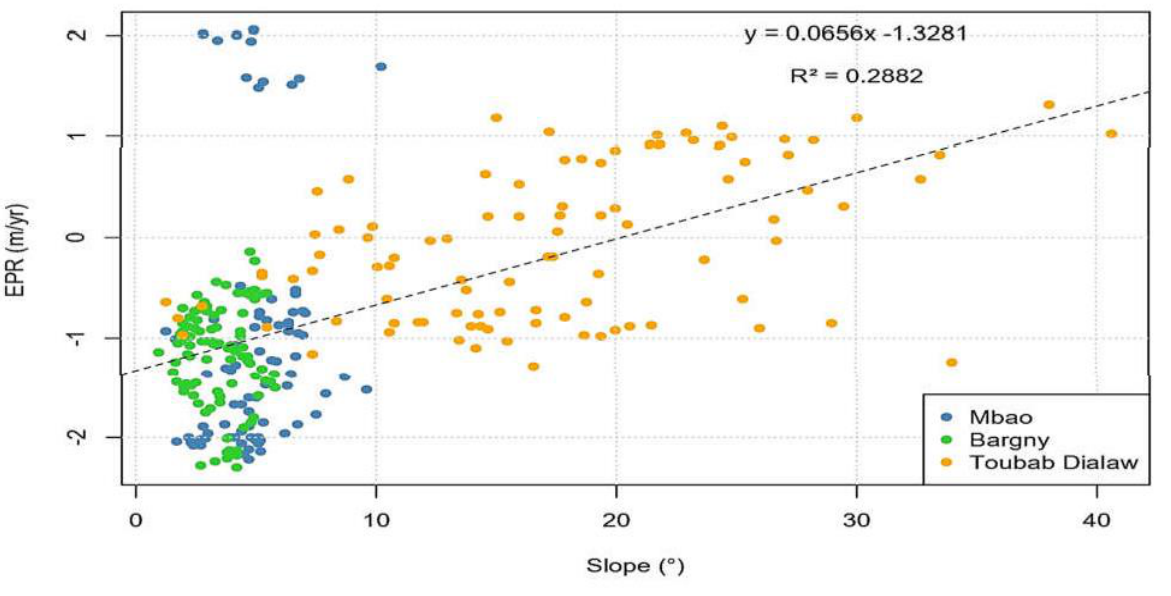
Figure 10. Cross plot of the shoreline change rate and slope in the three littoral cells.